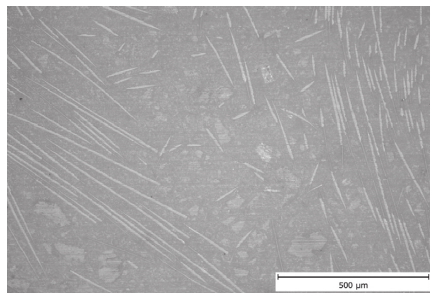
Figure 13: Differently oriented glass fibres.